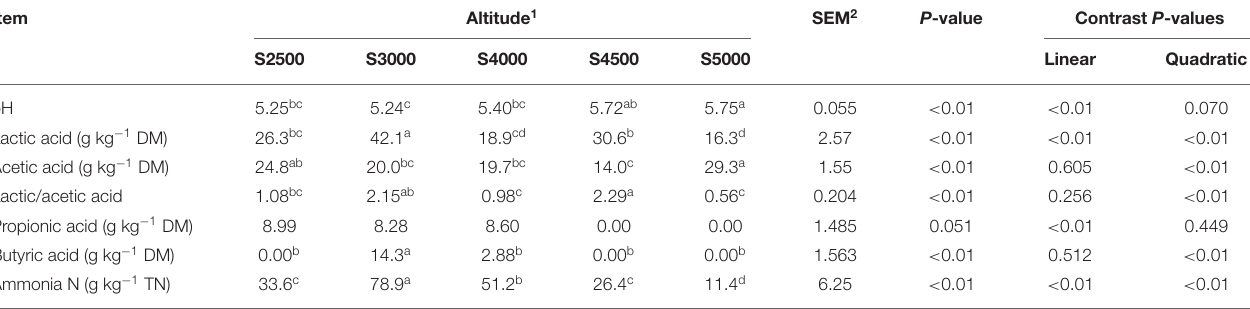
TABLE 3 | Fermentation profiles of K. pygmaea silage along the elevation gradient on the Tibetan Plateau. Item Altitude